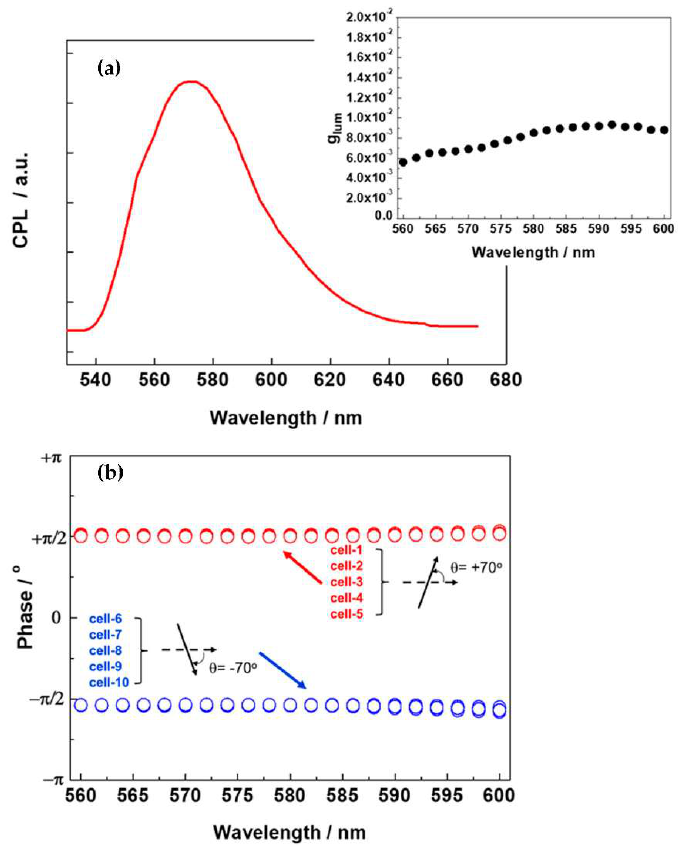
Figure 4. ( a ) A typical CPL spectrum obtained from cells with the extrinsic TN platform at a twisted angle of θ = + 70 ◦ . The calculated g lum values are depicted in the inset plot; ( b ) phase ( − π / 2 or + π / 2) of the modulated CPL signal from the cells with extrinsic TN platforms with a twisted angle θ = − 70 ◦ and θ = + 70 ◦ .